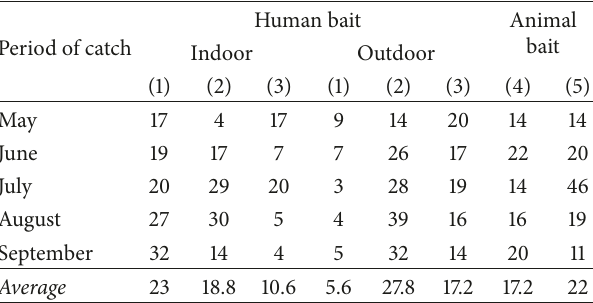
Table 1: Profile of Anopheles mosquito species and the average number of each species with human and animal